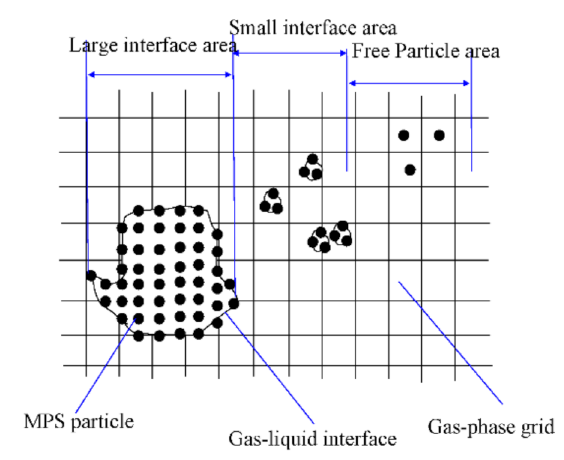
Figure 12. Two-phase coupling partition.